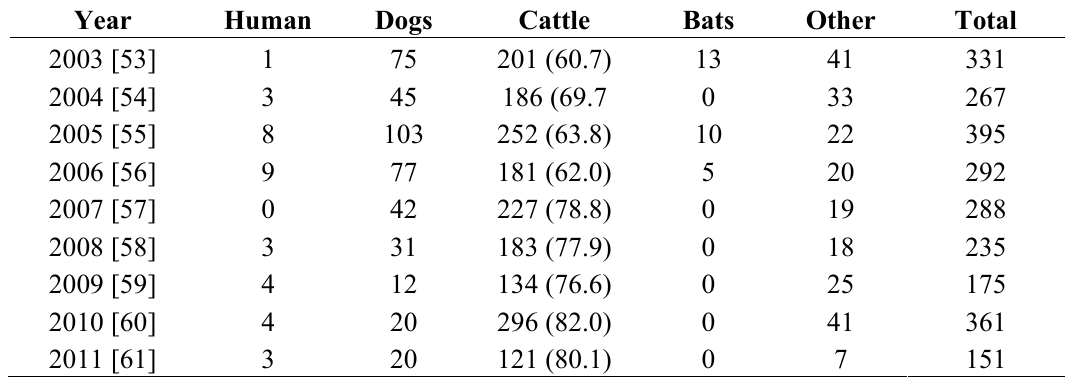
Table 3. Rabies cases reported in Mexico between 2003–2011 from ―Rabies surveillance in the United States during 2003–2011‖. The source references are included in the year